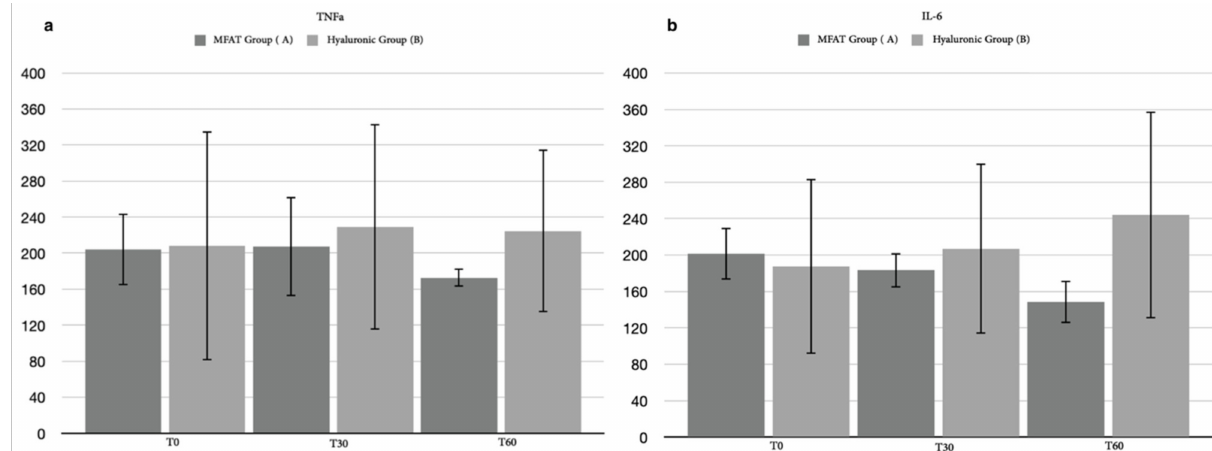
Figure 10. Difference of the necrosis tumor factor α (TNF α ) ( a ) and interleukin-6 (IL-6) ( b ) between hyaluronic group and MFAT group after 30 days and after 60